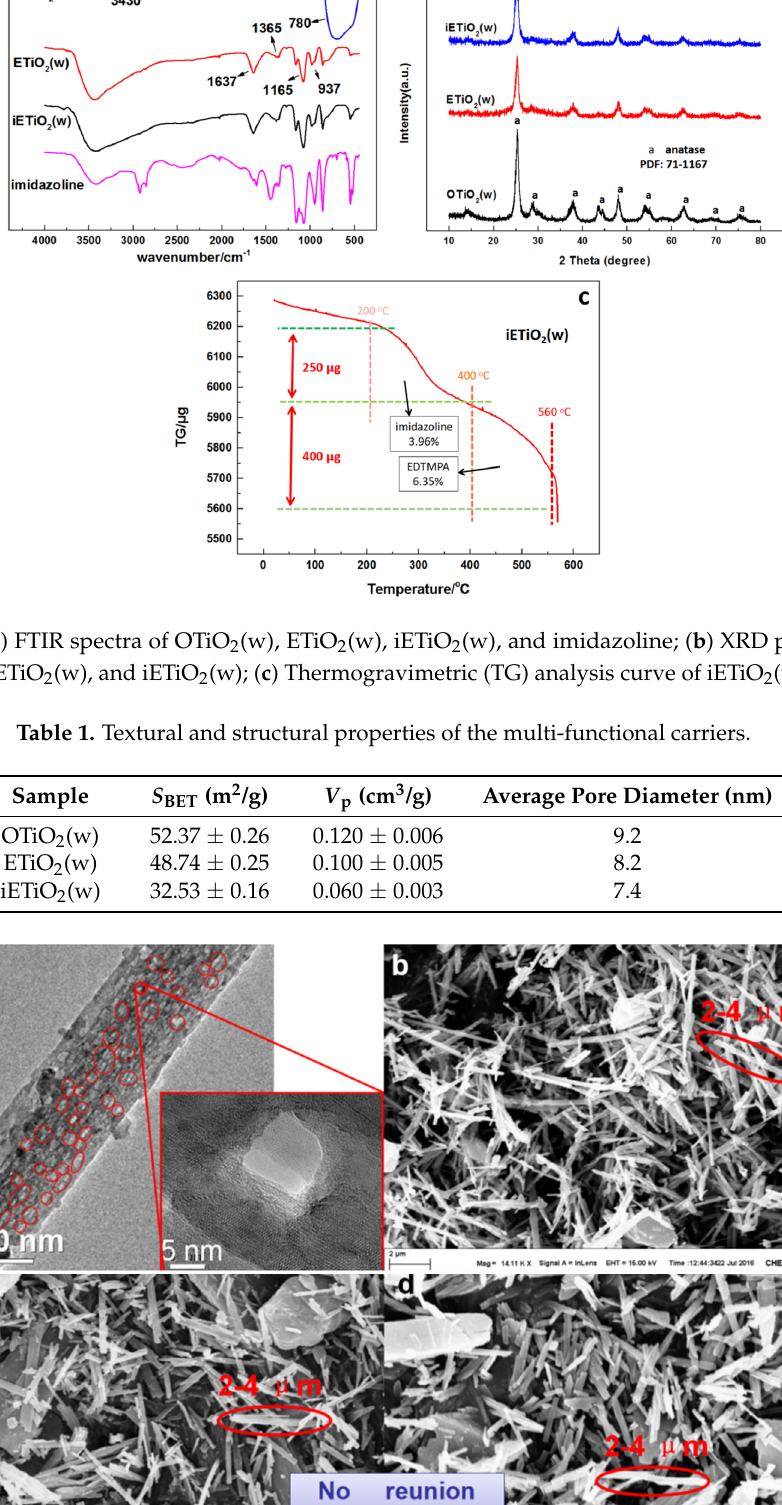
Figure 2. TEM image ( a ) of OTiO 2 (w), SEM images of ( b ) OTiO 2 (w), ( c ) ETiO 2 (w), and ( d ) iETiO 2 (w).